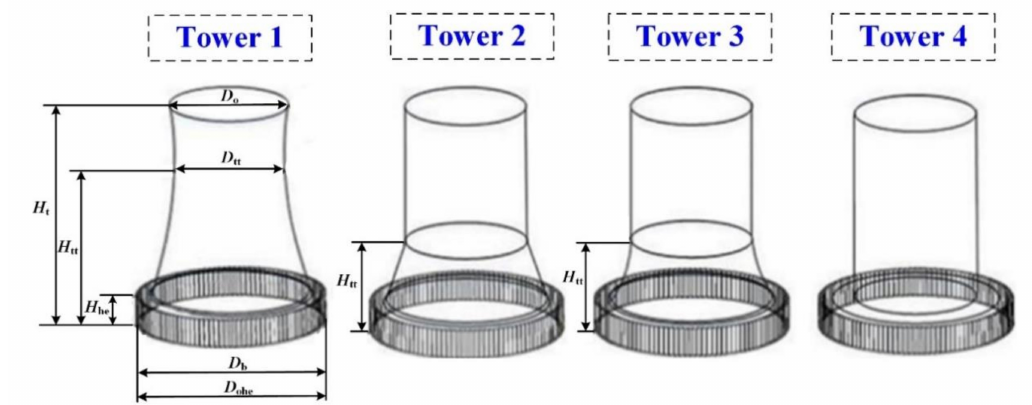
Figure 1. Steel-truss natural draft dry cooling system (NDDCSs) with different tower configurations.